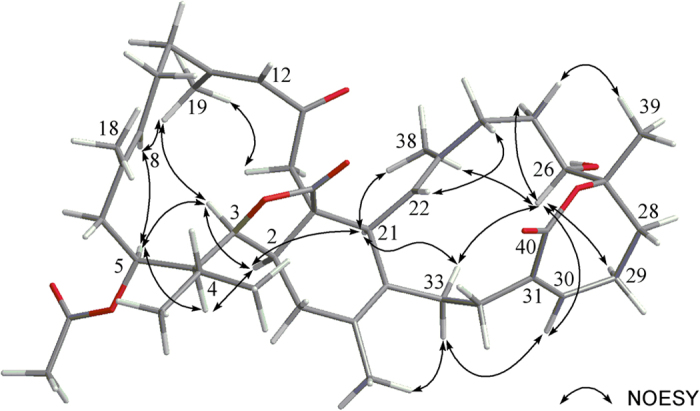
Selected NOE correlations for 1.